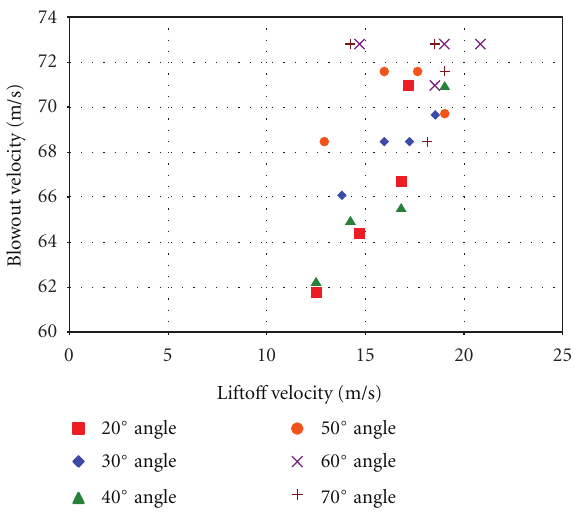
Figure 6: Blowout velocity versus lifto ff velocity.